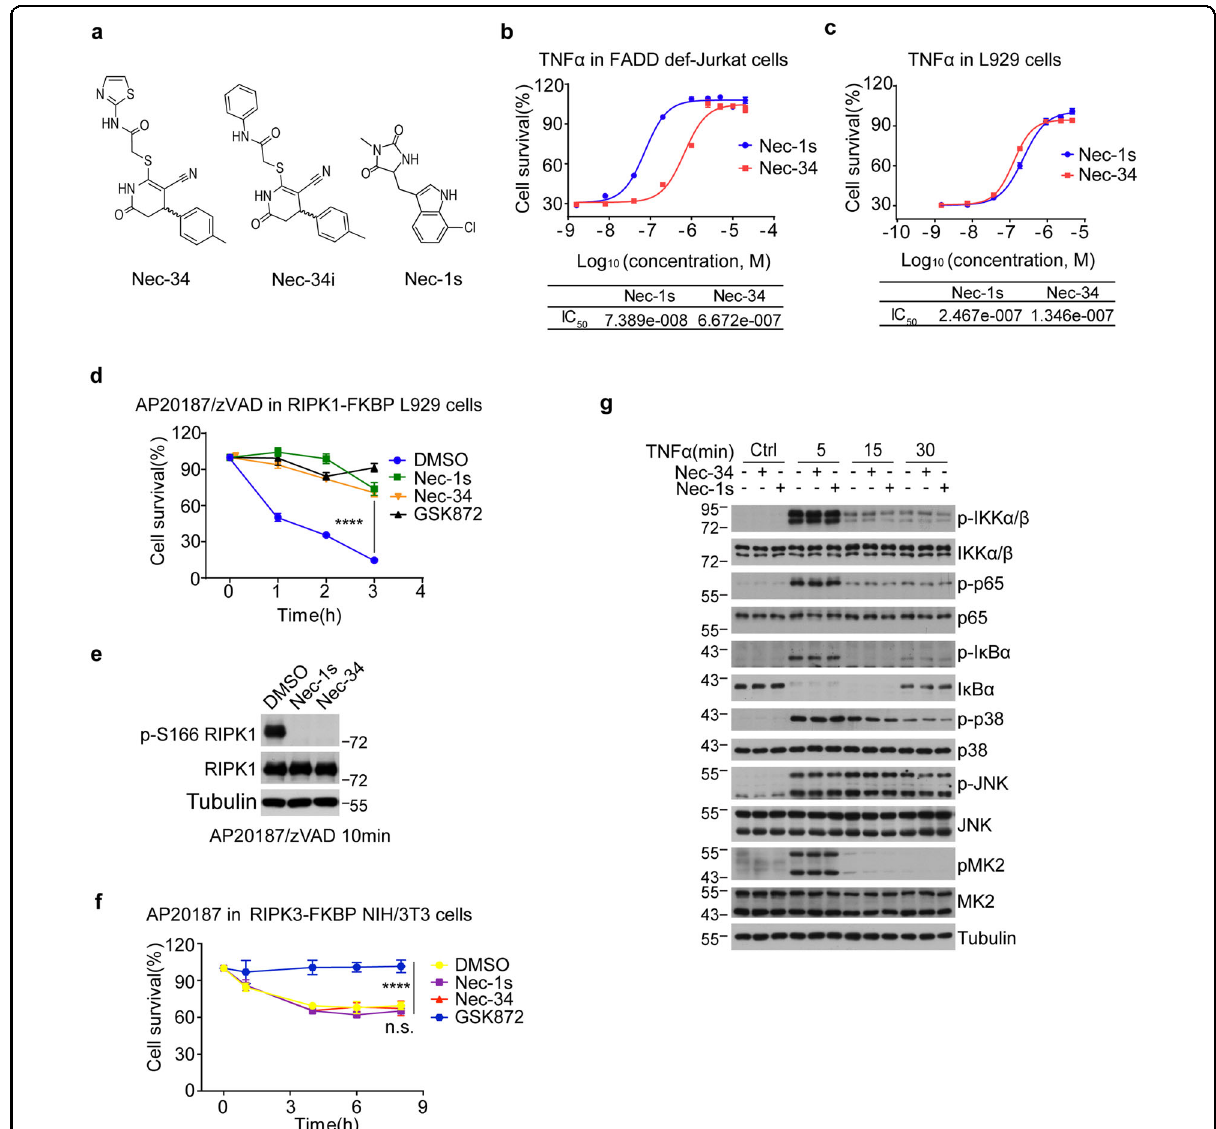
cells ( b ) and L929 cells ( c ) were pretreated with different concentrations of Nec-1s or Nec-34 for 30 min and then TNF α was added for additional 16 h. d , e RIPK1 KO L929 cells were infected with retrovirus expressing Flag-tagged WT mRIPK1-FKBP using the Tet-On Advanced Inducible Expression System. RIPK1-reconstituted L929 cells were treated with 1 μ g/mL doxycycline for 48 h to induce RIPK1 expression. The cells were then treated with 10 μ M Nec-1s, Nec-34 or GSK872 for 30 min and then 1 nM AP20187 and 50 μ M zVAD.fmk were added for indicated periods of time ( d ). The RIPK1 kinase activity was analyzed by western blotting with the indicated antibodies ( e ). f RIPK3-FKBP NIH/3T3 cells were pretreated with 10 μ M Nec-1s, Nec-34 or GSK872 for 30 min and then 2 nM AP20187 was added for additional periods of time. g L929 cells were pretreated with 10 μ M Nec-1s or Nec-34 for 30 min and then 100 ng/mL TNF α was added for indicated periods of time. The cell lysates were analyzed by phosphorylated and